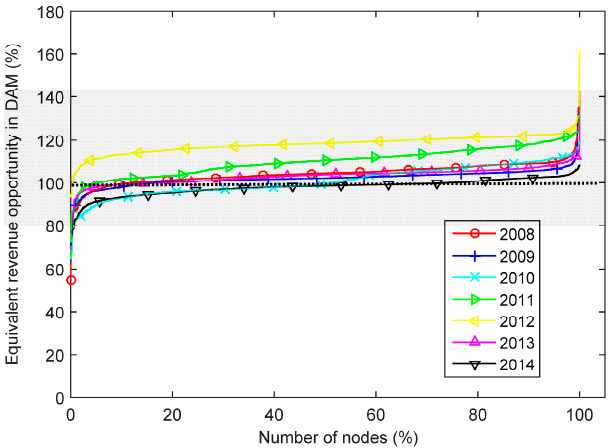
Figure 22. Potential revenue of a 10 MWh ESS dispatched in the RTM using DAM settlement prices as forecast divided by the potential revenue in DAM.